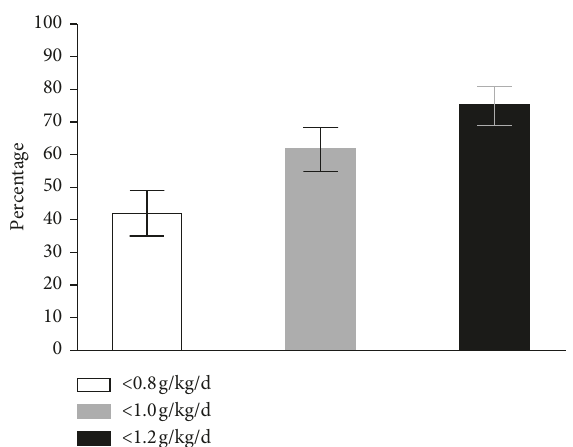
Figure 1: Inadequate protein intake per day in middle- to older- aged Mexican adults attending the Geriatrics Department at Western General Hospital, Zapopan, Jalisco, M´exico ( n Bars represent the percentage of participants with inadequate protein intake per day for each cut point. Whiskers represent 95% confidence intervals. g/kg/d: grams of protein per kilogram of body mass per day. Table 1: Inadequate protein intake per meal in middle- to older- aged Mexican adults attending the Geriatrics Department at the Western General Hospital, Zapopan, Jalisco, M´exico ( n